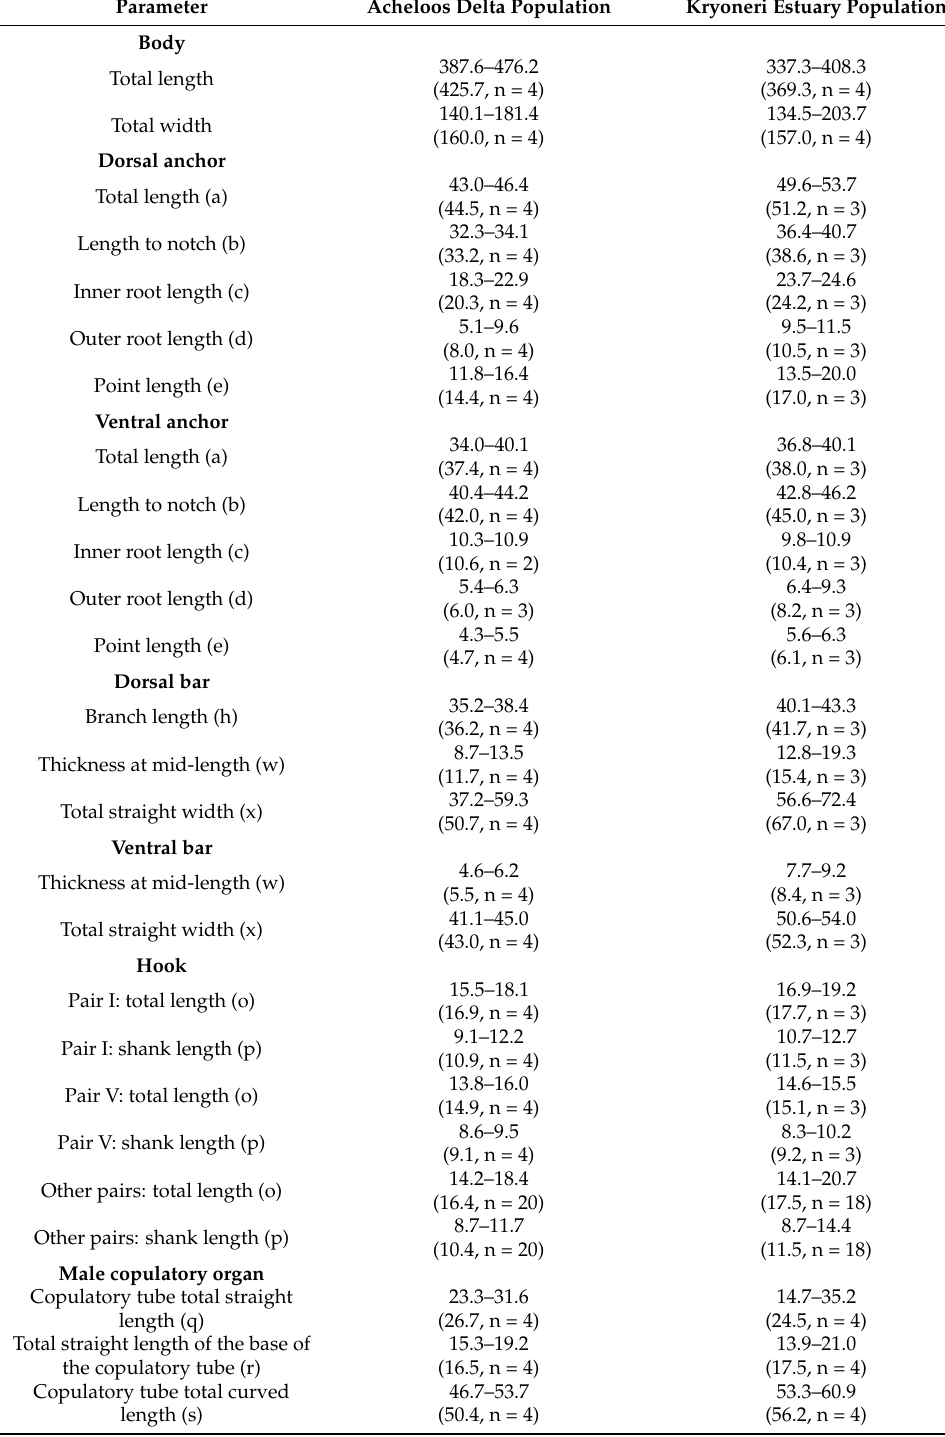
Table 3. Morphometric data of the haptoral and genital hard parts of specimens of Xenoligophoroides cobitis sampled in Greece. Measurements and their symbols follow Sasal et al. [16] with terminology adapted from ˇRehulkov á et al. [38]; measurements, all in µ m, are presented as the range, followed by the average and the number of measured structures (n) in